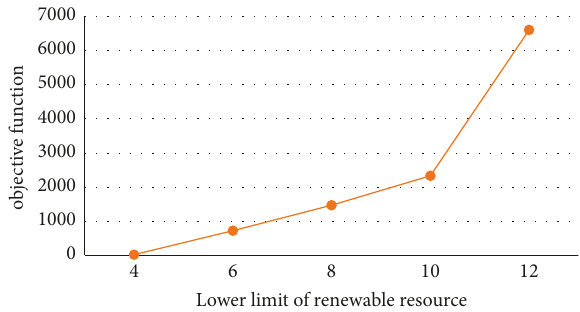
Figure 4: The amount of change in the objective function by increasing the lower limit of the renewable resource.